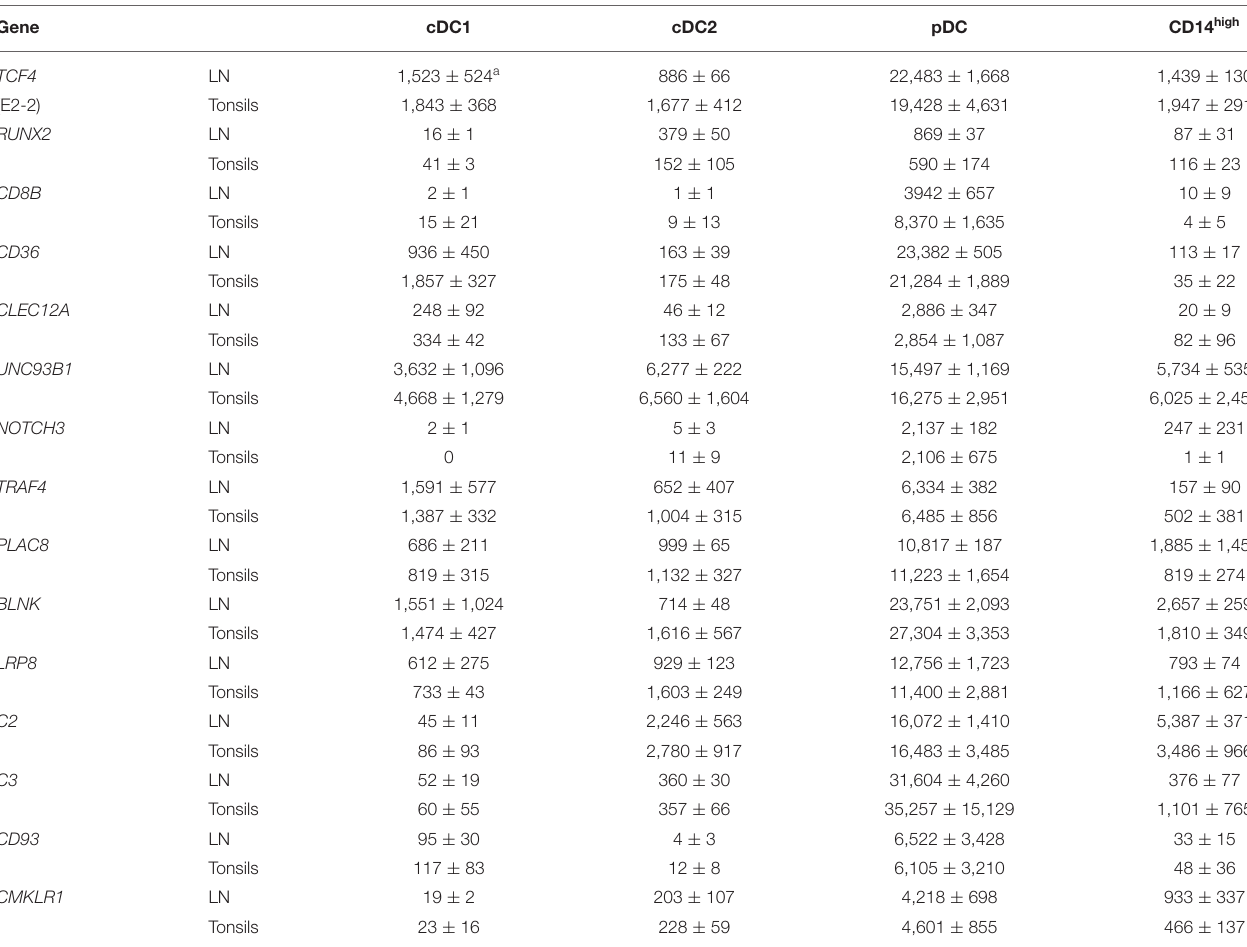
TABLE 4 | Differentially regulated genes in pDC. Gene cDC1